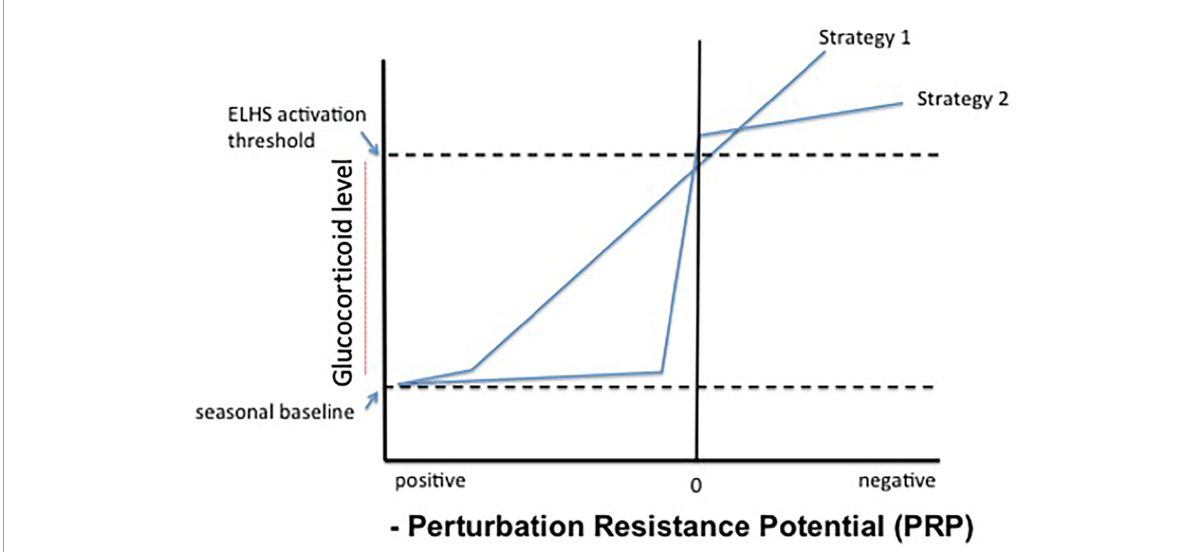
FIGURE5 Possible relationships between integrated perturbation resistance potential (PRP) and circulating glucocorticoid levels. Strategy 1 shows a continuous and linear relationship between PRP and corticosterone, effectively substituting PRP for allostatic load in previous versions of the model. In strategy 2, only negative energy balance, or acute perception thereof (PRP ≤ 0) results in sharply elevated corticosterone levels that promptly trigger an emergency life-history stage